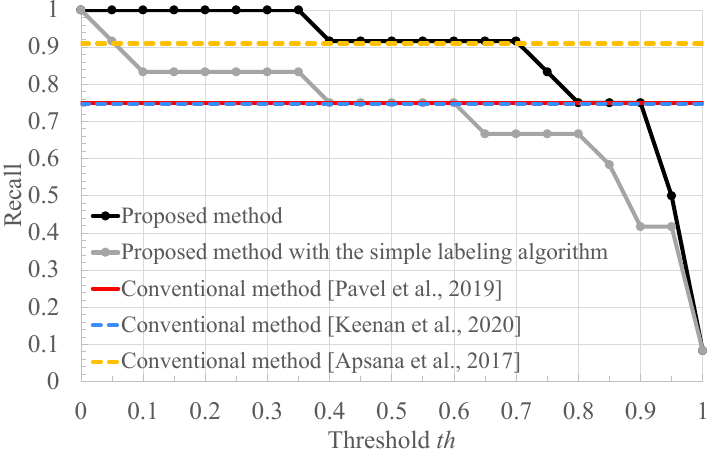
Figure 9. The recall of the conventional methods [8–10], the proposed method with the simple labeling algorithm, and the proposed